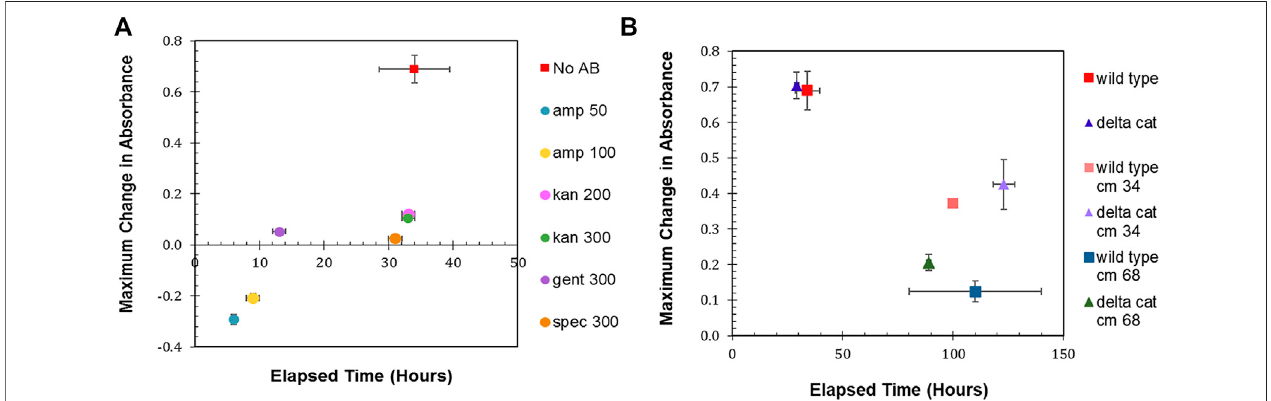
FIGURE 1 | Antibiotic sensitivity. (A) Wild type R. palustris ’ change in absorbancein response to the addition ofantibiotics (commonly used in synthetic biology) to themediaandgrowthrecordedovertime. “ NoAB ” iswildtype R.palustris withoutanyantibioticsaddedtothemedia.Amp50andAmp100are50 μ g/mland100 μ g/ml ampicillinrespectively.Kan200andKan300are200 μ g/mland300 μ g/mlkanamycinsulfaterespectively.Gent300andSpec300are300 μ